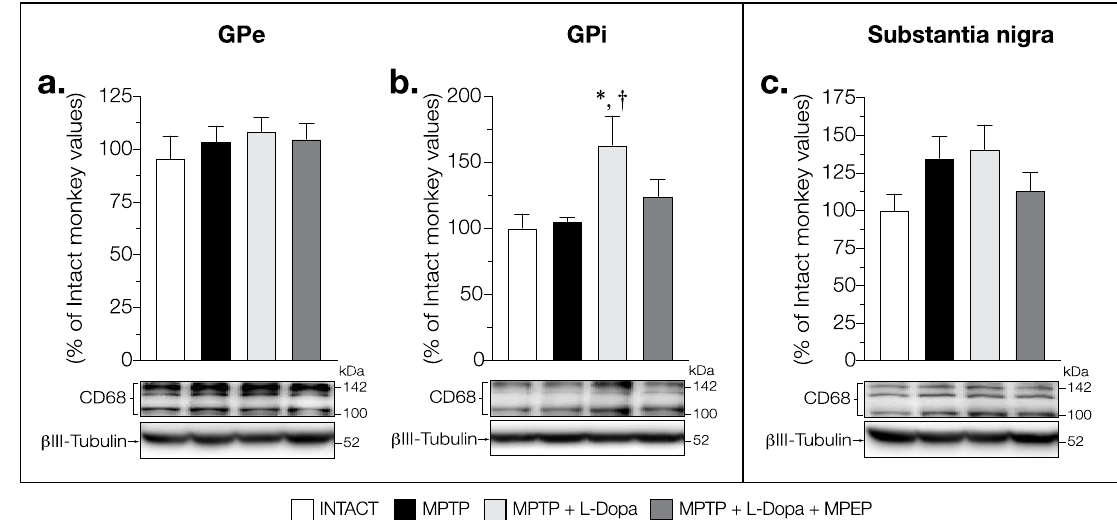
Figure 10. Western blots for CD68 protein levels in ( a ) GPe, ( b ) GPi and ( c ) substantia nigra of intact monkeys (control), MPTP monkeys treated with saline, L-Dopa and L-Dopa + MPEP. Values are means of arbitrary units expressed as percentage of control ( β III-tubulin was used as internal loading control) of 3–5 independent experiments ± standard error of mean of 4–5 monkeys per group. * p < 0.05 vs. INTACT; † p < 0.05 vs. MPTP.